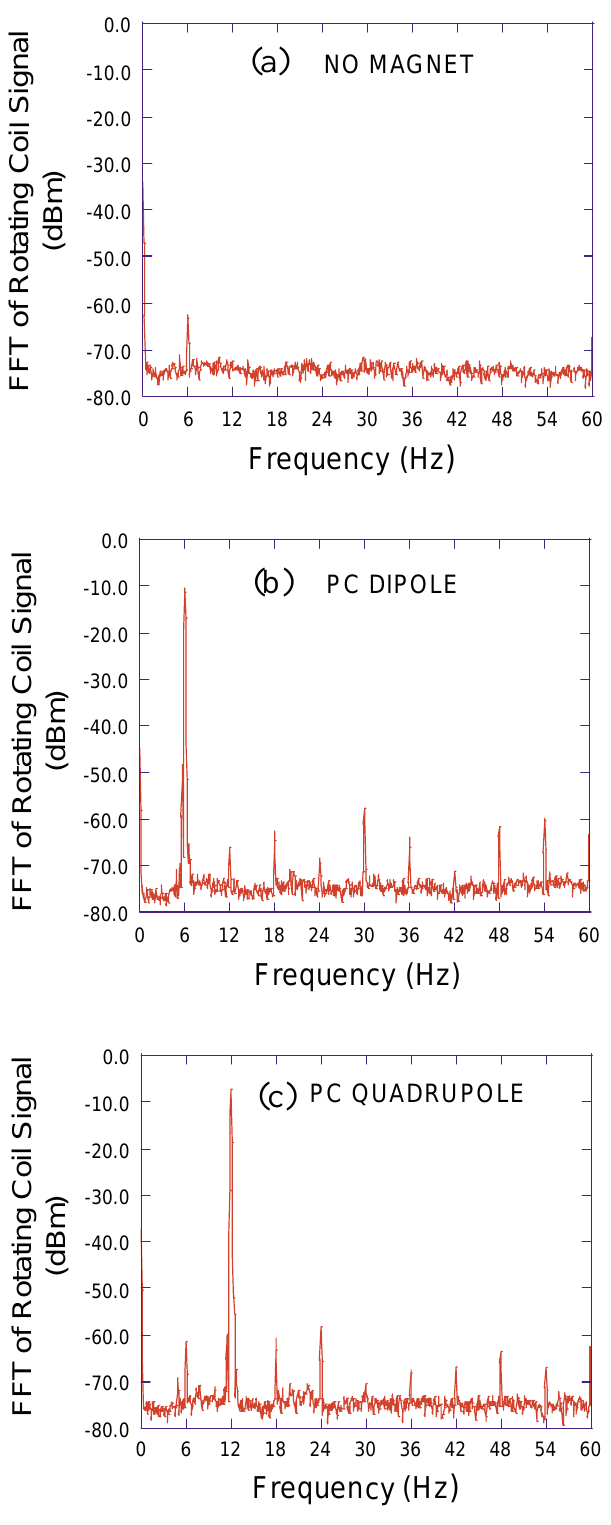
FIG. 7. (Color) Fast-Fourier transform signal from digital scope with (a) no current on the PC magnet, and mu-metal shield present, (b) powered PC dipole magnet (2 A), and (c) powered PC quadrupole magnet (2 A). The rotating coil spins at 6 6 0.001 Hz; the FFT is calculated every 10 s and the average over 5 min is